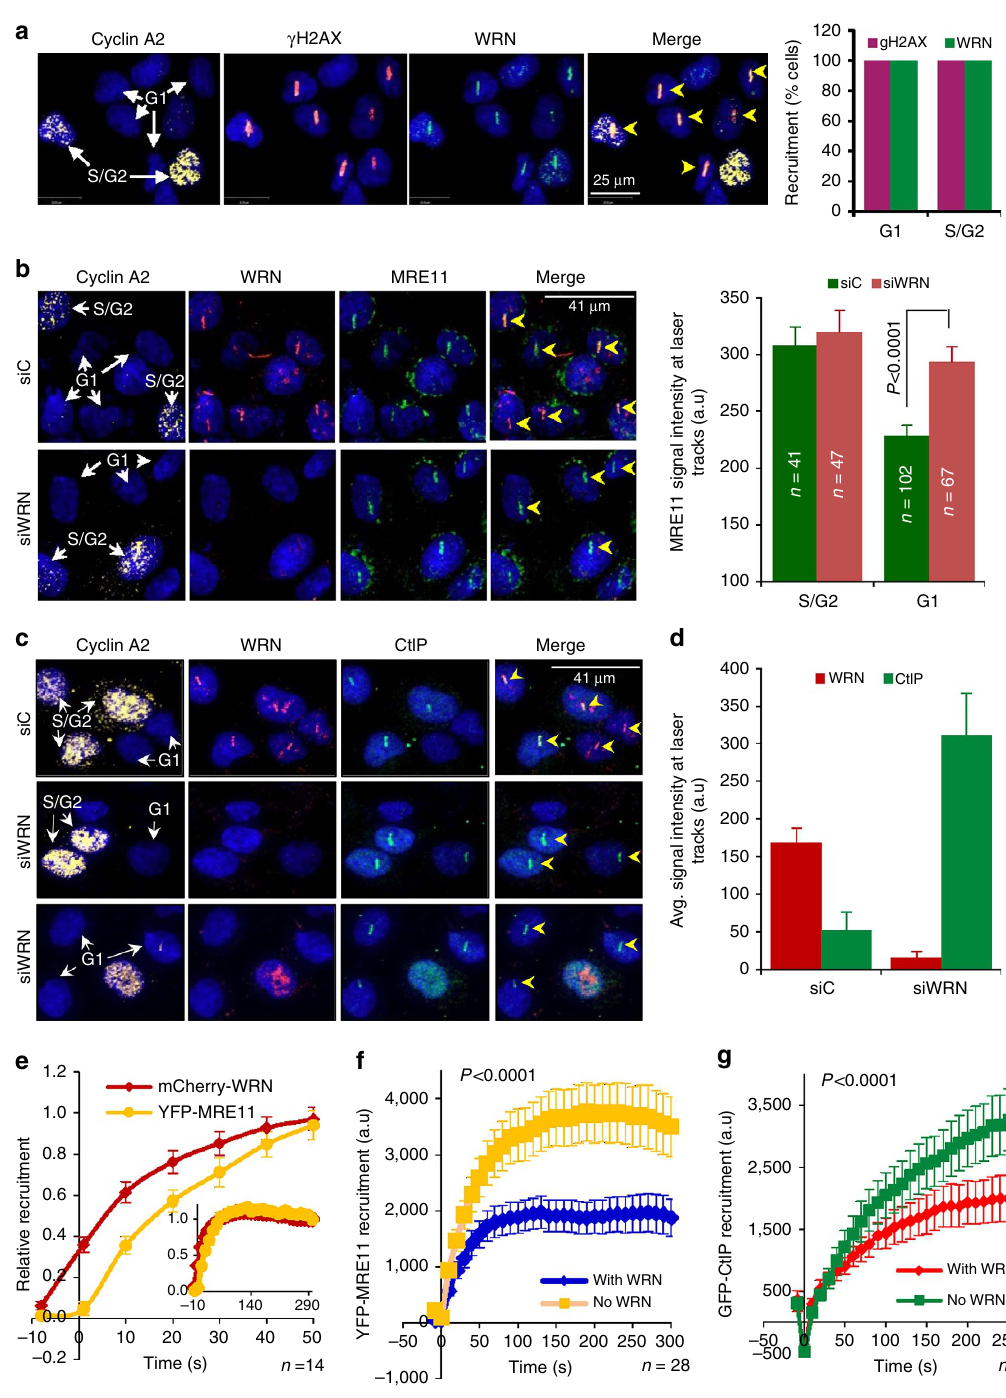
Figure 4 | WRN inhibits the recruitment of MRE11 and CtIP to DSBs. ( a ) Confocal microphotographs showing cell cycle independent recruitment of WRN to laser-induced DSBs in U2OS cells. Graph represents data from 4 200 cells. gH2AX; gamma H2AX. ( b ) WRN depletion increases MRE11 recruitment to DSBs in G1 cells. siRNA transfected U2OS cells were microirradiated and immunostained for cyclin A2, WRN and MRE11. Graph indicates MRE11 recruitment to laser-induced DSBs in control and WRN siRNA transfected S/G2 and G1 cells. n; number of cells. ( c ) WRN knockdown promotes CtIP recruitment to laser-induced DSBs. Control (siC) and WRN knockdown U2OS cells were microirradiated to generate DSBs and immunostained with WRN, CtIP and cyclin A2 antibodies. Cyclin A2 positive cells indicate cells in S/G2 phase. ( d ) Quantitation of CtIP and WRN signals at DSBs as seen in panel E. n ¼ 26 cells per set ( e ) Recruitment kinetics of mCherry-WRN and YFP-MRE11 to laser-induced DSBs in U2OS cells. n ¼ 14 cells ( f ) Real-time recruitment of YFP-MRE11 to laser-induced DSBs in WS cells, AG11395, expressing no WRN (vector control) and mCherry-WRN. n ¼ 28 cells ( g ) Recruitment of GFP- CtIP to laser-induced DSBs in AG11395 WS cells transfected with or without mCherry WRN. n ¼ 22 cells. Yellow arrow heads in panel A, B and C indicate laser-induced DSB tracks. a.u., arbitrary